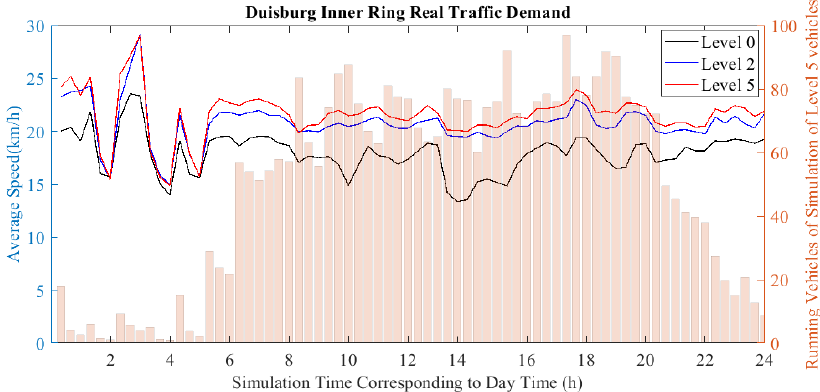
Figure 8. Comparison of average speeds of vehicles with different automation levels in real traffic volume (100% traffic volume).